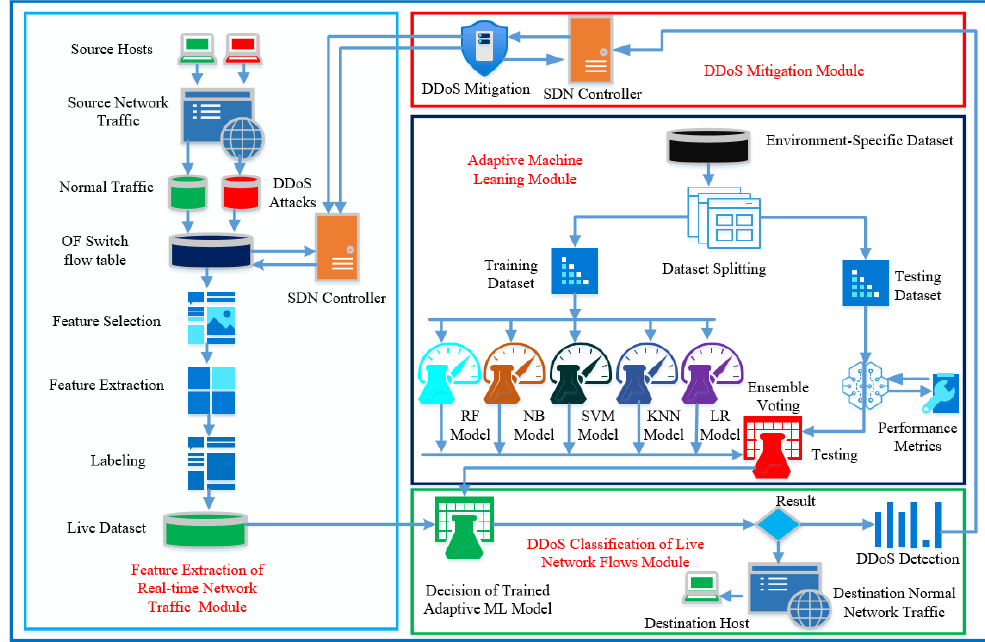
Figure 5. Flowchart and work mechanism of DDoS detection and mitigation system of